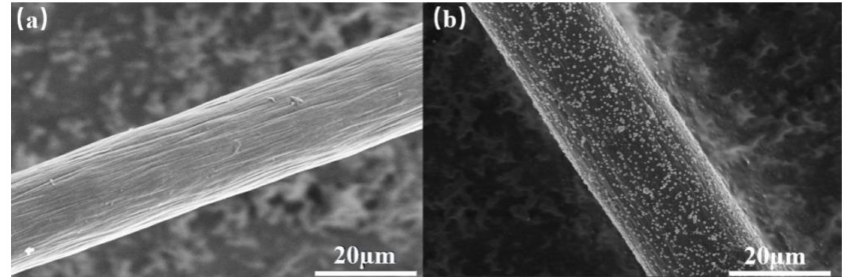
Figure 3. SEM of cathode: ( a ) raw carbon felt electrode and ( b ) Pd-loaded carbon felt electrode (0.5 mg/cm 2 ).